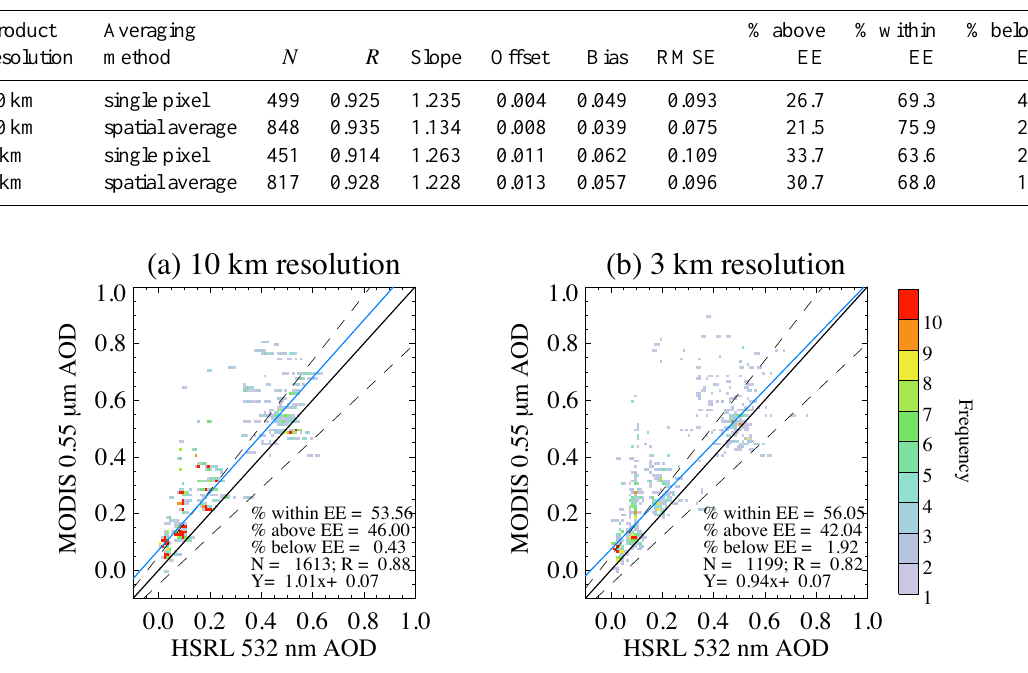
Fig. 7. Density scatter plot of MODIS/HSRL collocations for AOD at 0.55µm for MODIS and 532nm for HSRL for the 10km MODIS product (a) and the 3km MODIS product (b) . The MODIS AOD is sampled along the HSRL flight path; no spatial or temporal averaging is performed. Expected error over land ( ± 0.05 ± 0.15AOD) is shown in the dashed lines, the best fit line is shown by the solid blue line, and the one-to-one line is shown in the solid black